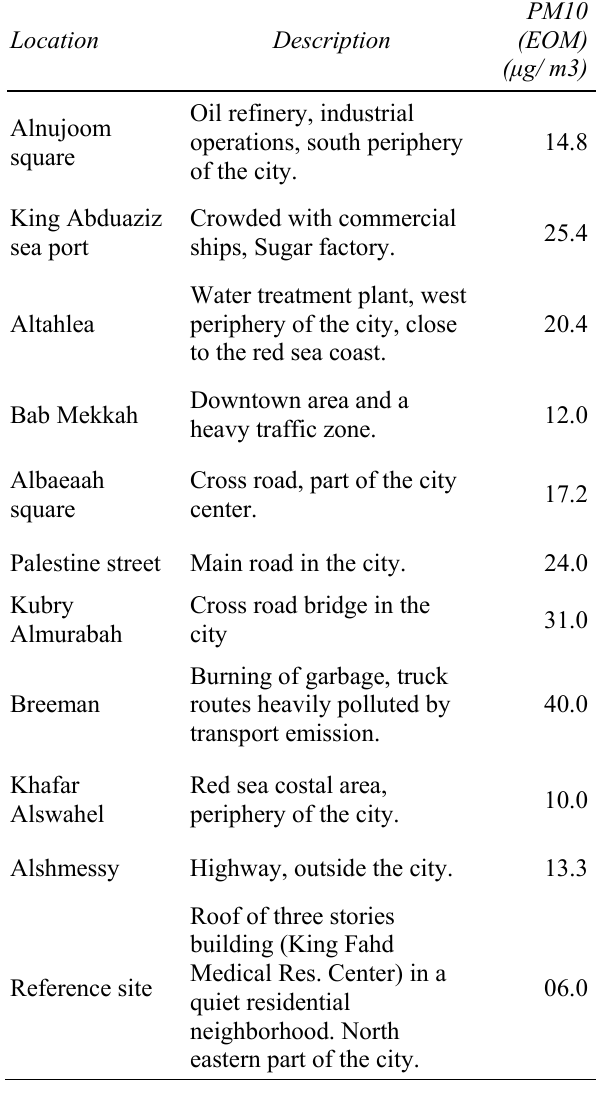
Table 1: Sampling sites in Jeddah city and the amount of EOM of particle matter (PM10) collected in 24 hours on glass fiber